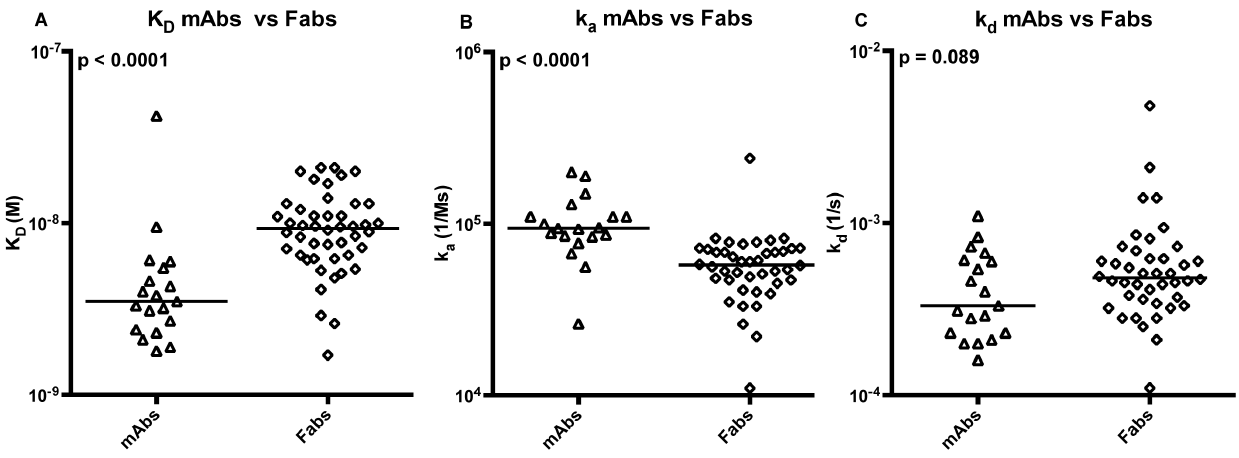
Figure 5. Binding Kinetics of TT-Specific mAbs from the Hybridomas and Fabs from the Phage Display Library. Different capture antibodies were used in SPR assays for mAbs (goat anti-mouse IgG1) and Fabs (goat anti-mouse IgG Fab), however, the design of the SPR assays allowed for direct comparison of the affinity values. (A) affinities (KD), (B) on-rates (ka), and (C) off-rates (kd) of TT-specific mAbs and Fabs were determined by SPR. The horizontal bars show the median values of each data set. Statistical comparisons were performed using the Mann Whitney U test.